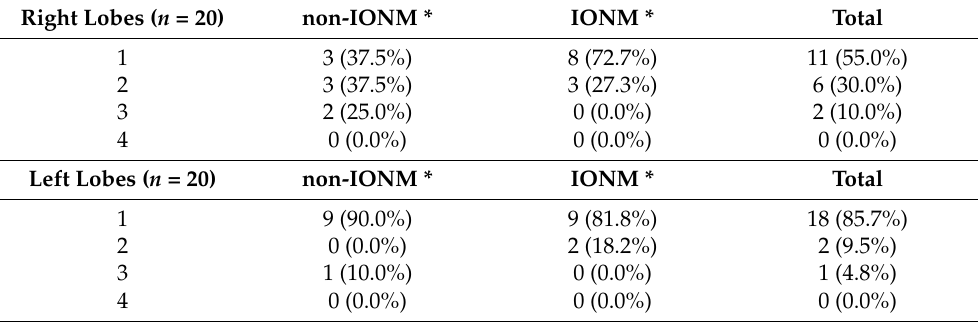
Table 3. Proportion of RLN † for LCT ‡ sections (allocated in Figure 2b) on right and left lobes. Right Lobes ( n = 20) non-IONM * IONM